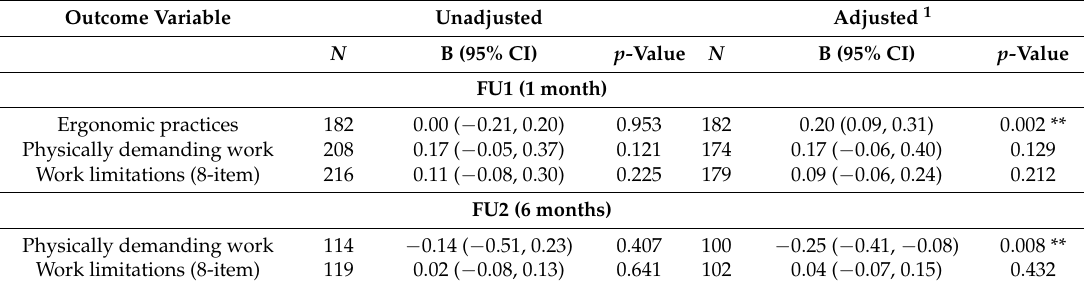
Table 5. Effects of the ARM intervention on Working Conditions and Enterprise Outcomes from baseline to FU1 (1 month) and FU2 (6